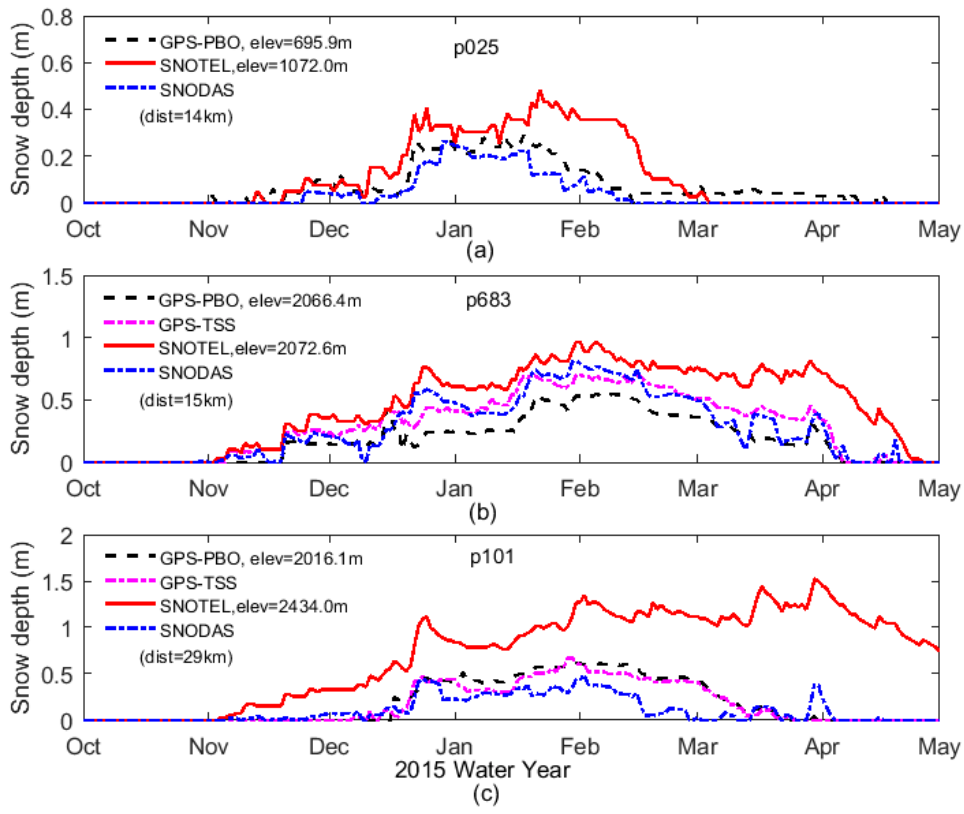
Figure 8. Snow depth time series derived with the GPS-PBO, GPS-TSS, SNOTEL, and Snow Data Assimilation System (SNODAS) during water year 2015 for p025 ( a ), p683 ( b ), and p101 ( c ). Table 3. Comparisons of snow depth estimates with different methods at p025 (on flat surface).